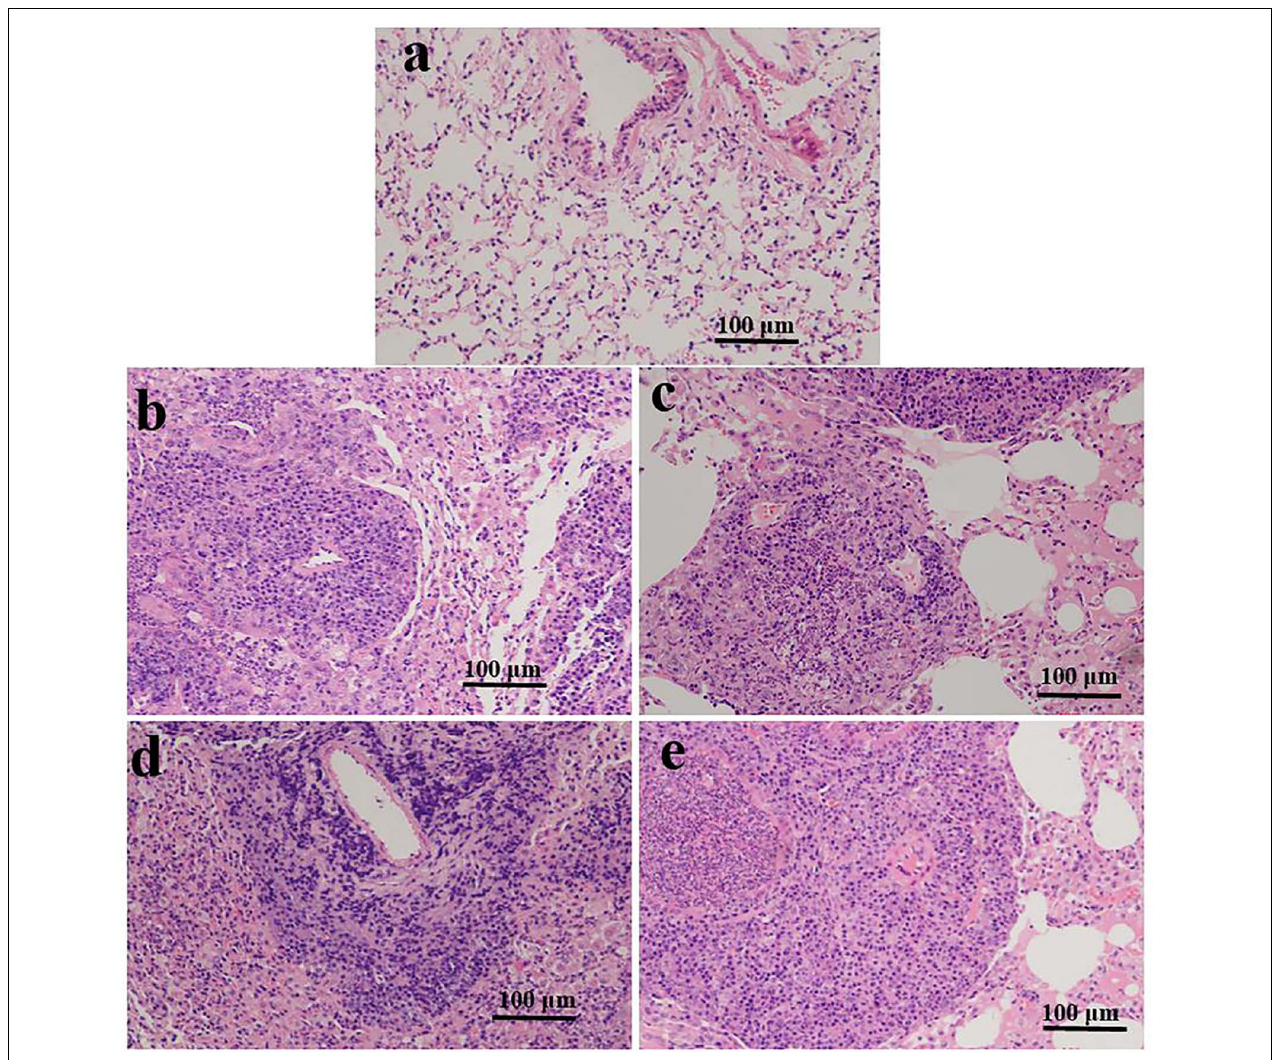
FIGURE 1 | Representative photomicrographs of HE-stained lung sections are shown for ART- and in vivo -conceived aged mice. The lungs of an in vivo -conceived female (a) , an IVF-conceived female (b) , an IVF-conceived male (c) , and an ICSI-conceived male (d,e) . Histology analysis are based on alveolar edema, hemorrhage, infiltration, or aggregation of neutrophils in the airspace or the vessel wall and thickness of the alveolar wall. Original magnification × 200. In (b–e) , lung architecture was compromised and a large number of inflammatory cells infiltrated in the alveolar interstitium.